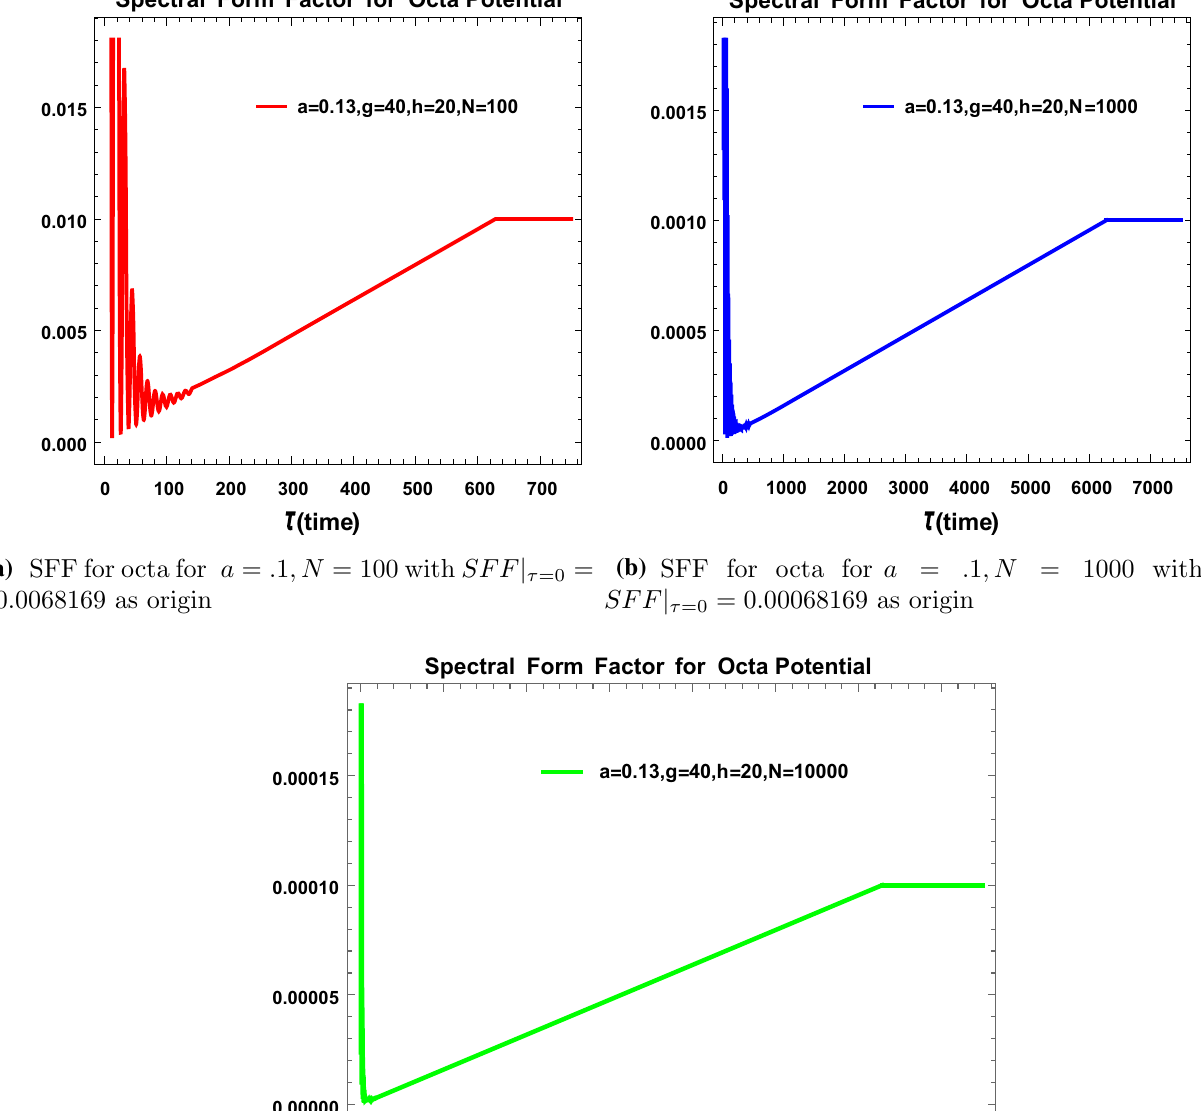
Fig. 33 Time variation of SFF for different N at β = 0. Here we shift reference axis[SFF] to SFF | τ = 0